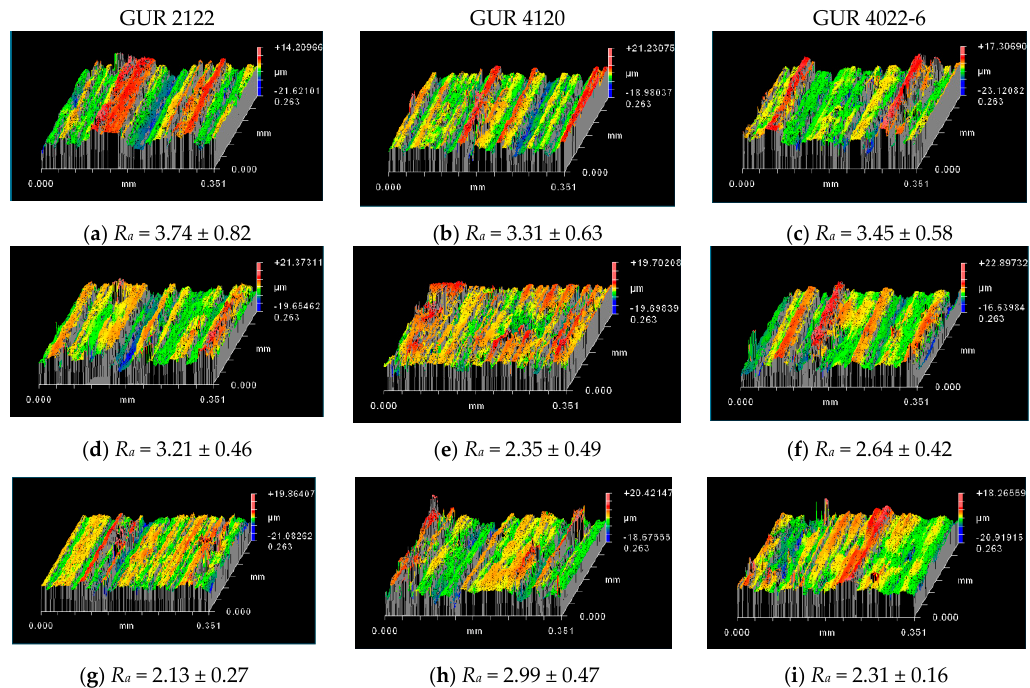
Figure 12. Optical profilometer 3D patterns of wear surface; abrasive wearing of neat UHMWPEE and